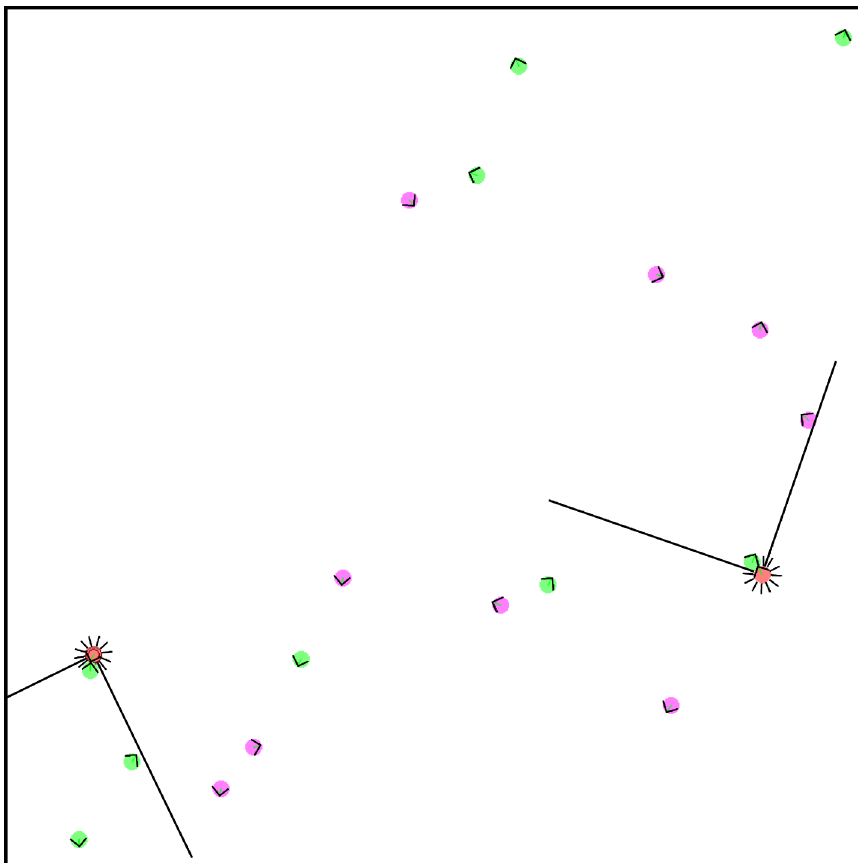
Fig 1. Screenshot of a robotic simulation. The red dots represent the two hunters, the green dots the hares, and the pink dots the stags. The black lines around the agents ’ body represent the proximity sensors and the black cones on front the cameras described in the text. Hunters are allowed to move throughout the environment. Hares and stags remain at their starting positions.